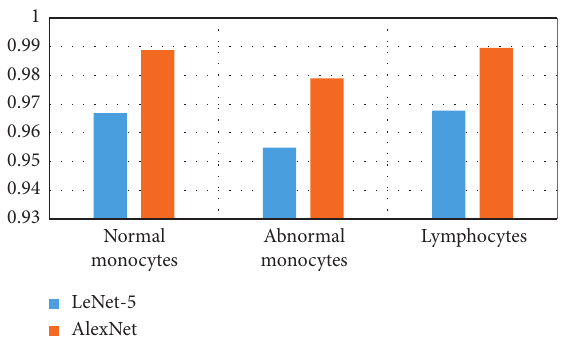
Figure 3: Performance comparison of both LeNet-5- and AlexNet- based models in terms of Accuracy in each class.